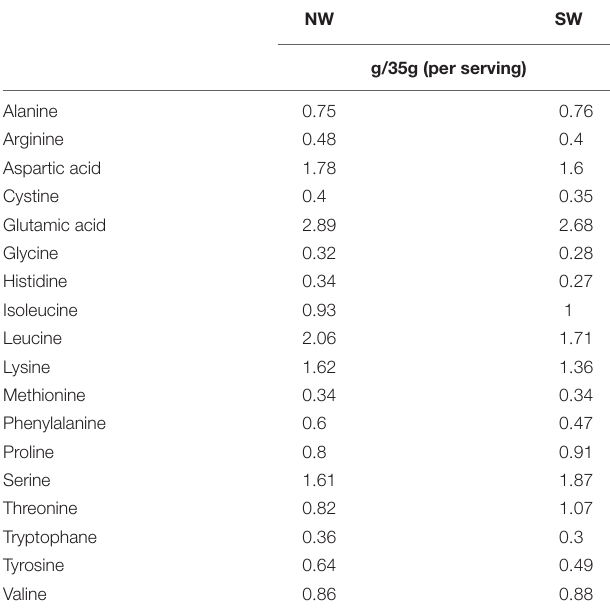
TABLE 3 | Amino acids composition (g) for 35 g (serving) of standard whey (SW) and native whey (NW) proteins.